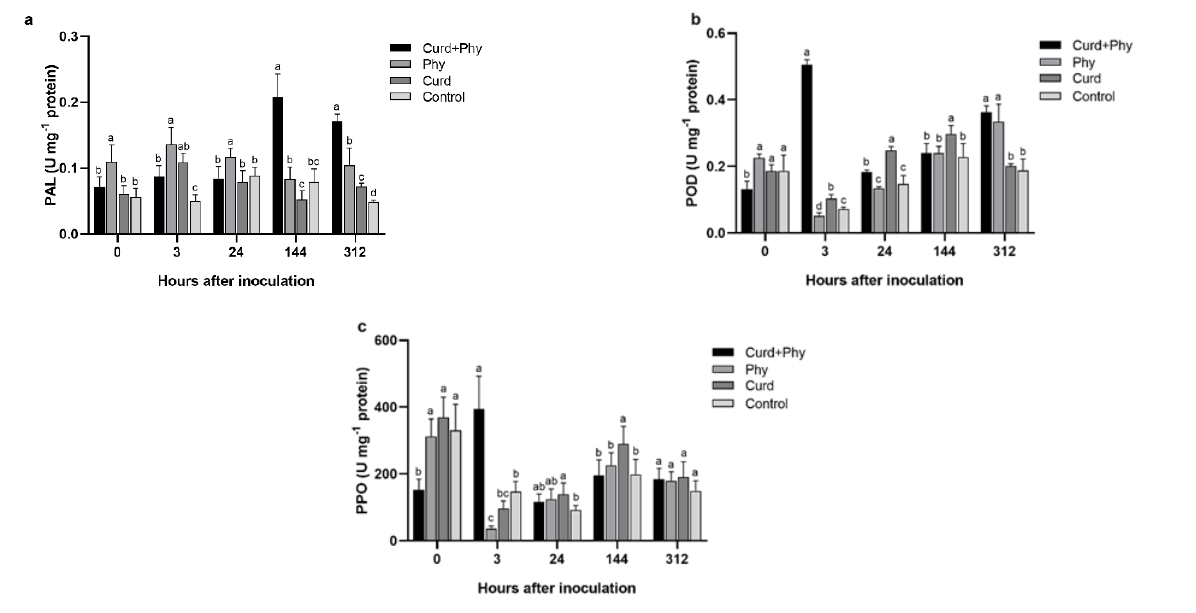
Figure 2. Effect of curdlan treatment on ( a ) PAL activity, ( b ) POD activity and ( c ) PPO activity from avocado plant leaves inoculated with P. Cinnamomi . Curd + Phy, Phy, Curd and Control represent application of curdlan one day before inoculation of P. Cinnamomi , inoculation of P. Cinnamomi , application of Curd without inoculation of P. Cinnamomi and the control (distilled water), respectively. Data are presented as the mean ± standard deviation for nine replicates. Means with the same letter are not significantly different (ANOVA followed by Tukey’s test at p < 0.05).